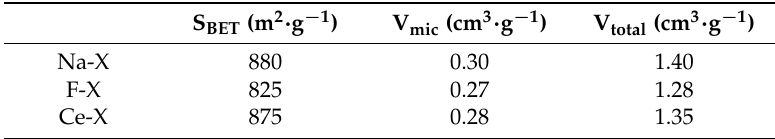
Table 1. BET-specific surface area (S BET ), micropore volume (V mic ) and total pore volume (V total ) of as synthesized Na-X, fluorinated F-X, and ion exchanged Ce-X zeolites.